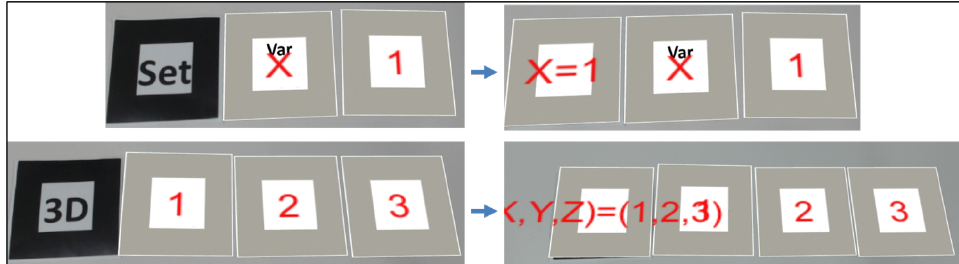
Figure 4. Examples of generating a virtual marker containing combined information from basic virtual markers. The first virtual marker (X = 1) is generated by a variable virtual marker (X) and a virtual number marker (1). The second is generated by three virtual number markers. The user can determine the information of the 3D vector marker by changing the marker selection